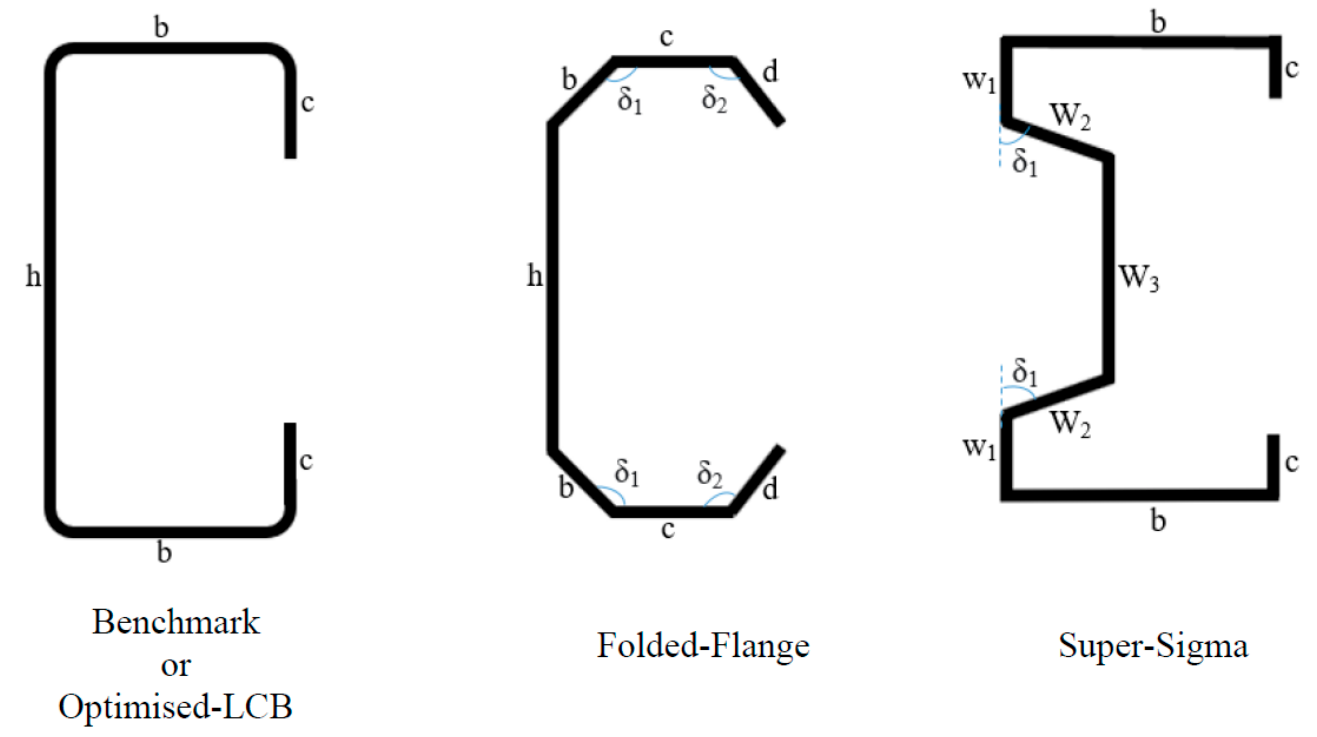
Figure 11. Illustration of selected section profiles.